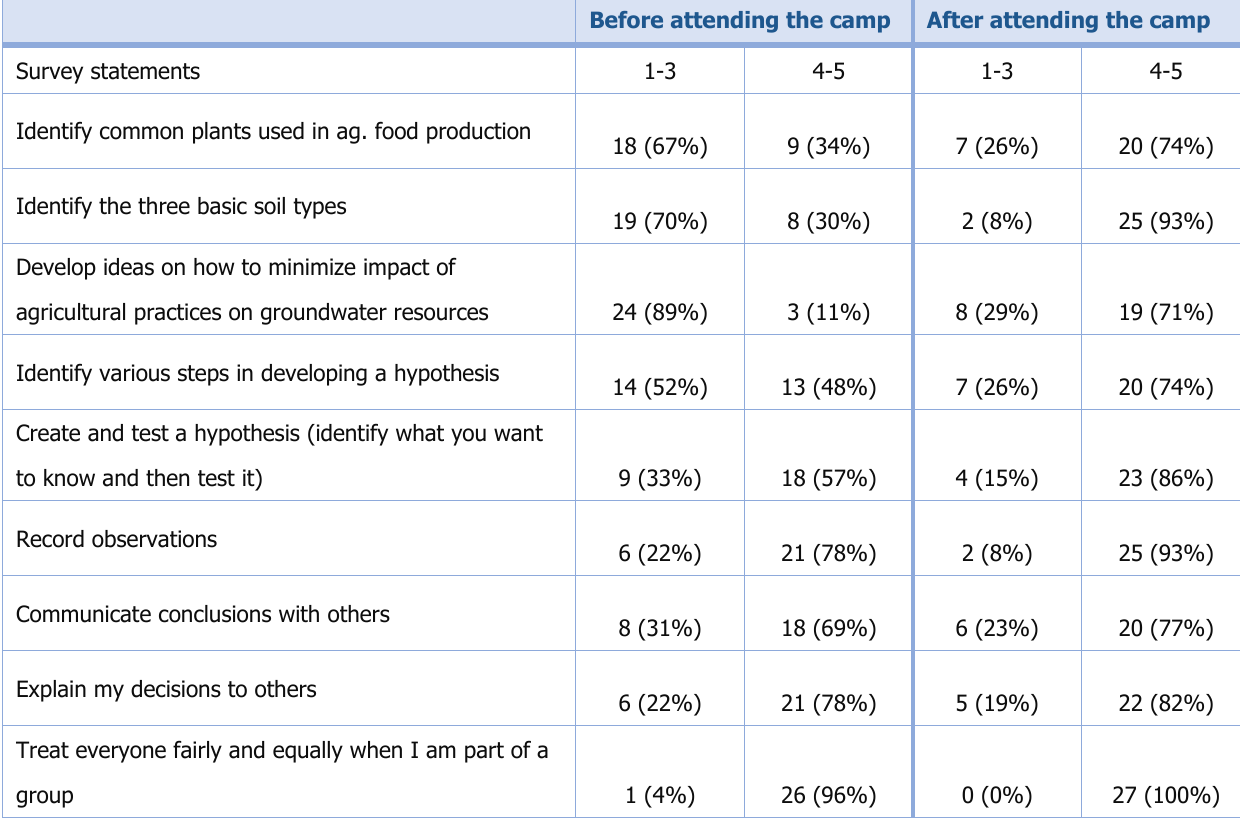
Table 2. Frequency Distribution of Students Based on Self-reported Skill